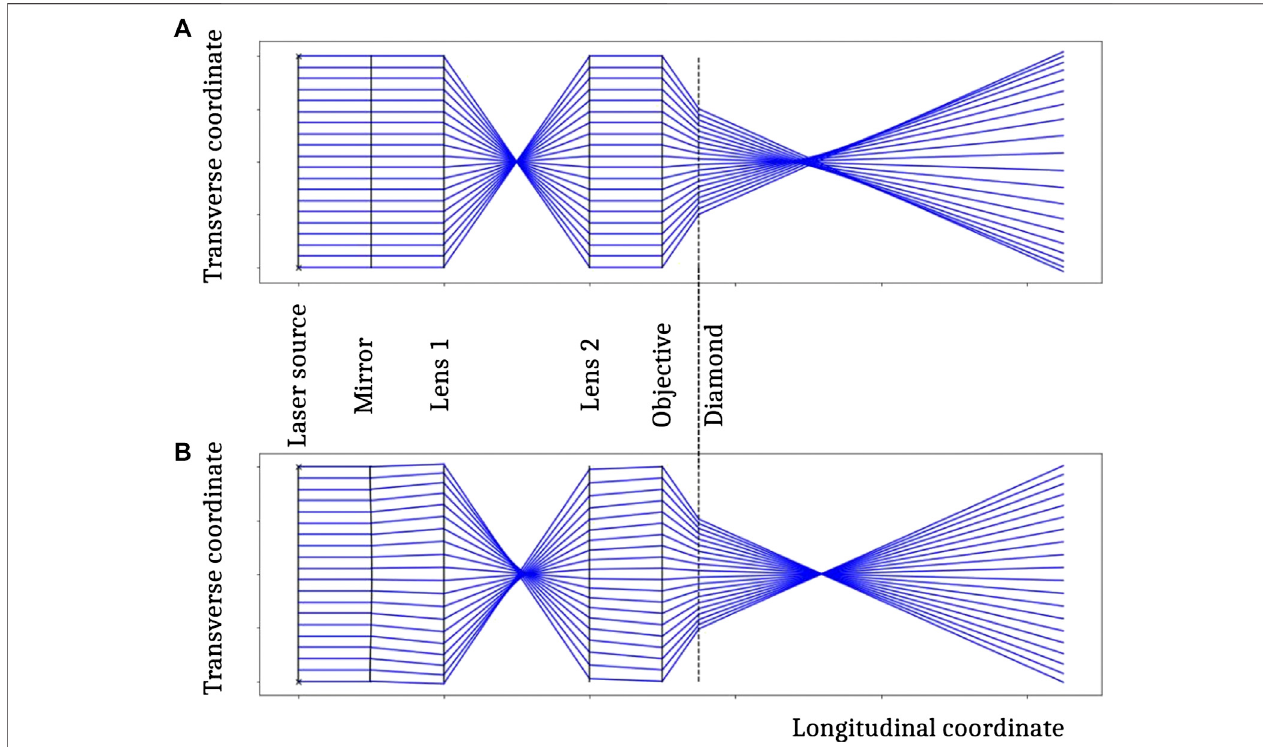
FIGURE 4 | Schematic representation of the optical effect of the diamond surface on the laser beam in absence of correction (A) and with the optimal mirror deformation (B) .